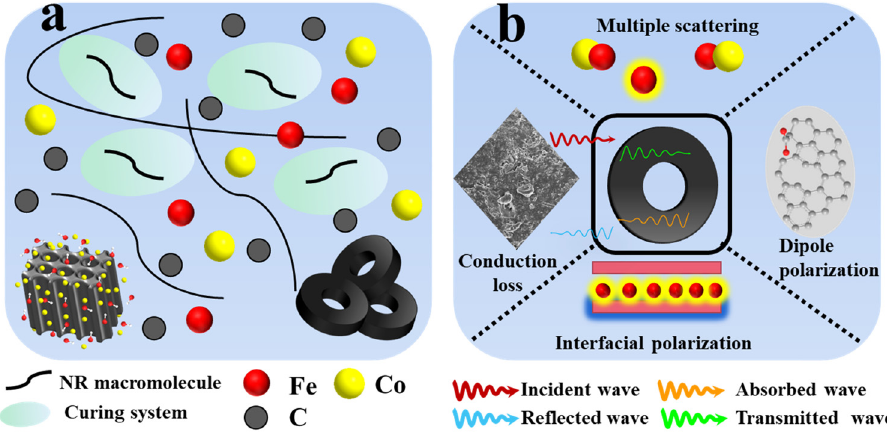
Figure 9: Schematic illustration of the microwave attenuation mechanism of NR/CoFe 2 O 4 @BC